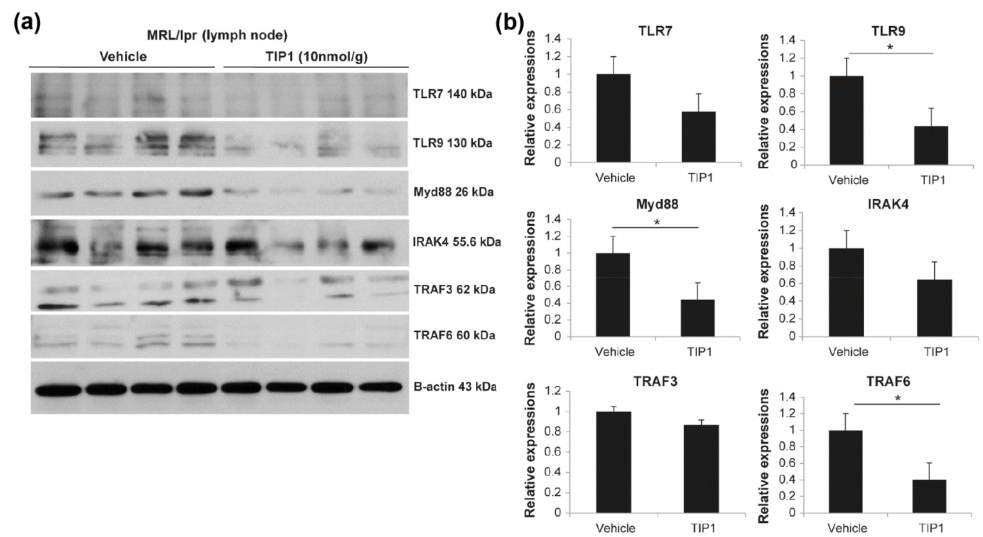
Figure 5. Inhibition of Toll-like receptor 7(TLR7)/TLR9 results in the blockade of the endosomal TLR signaling pathway in the lymph nodes. ( a ) The expression of total proteins related to the endosomal TLR signaling was analyzed by Western blotting using lymph nodes from female lupus-prone mice (MRL/ lpr ). ( b ) Western blot data were quantified using a densitometer (* P < 0.05, Mann–Whitney U test). n = 4 mice/group. The experiments were repeated at least twice. TIP1, Toll-like receptor inhibitor peptide 1; MyD88, myeloid differentiation factor 88; IRAK4, interleukin-1 receptor-associated kinase 4; TRAF3, tumor necrosis factor receptor-associated factor 3; TRAF6, tumor necrosis factor receptor-associated factor 6.